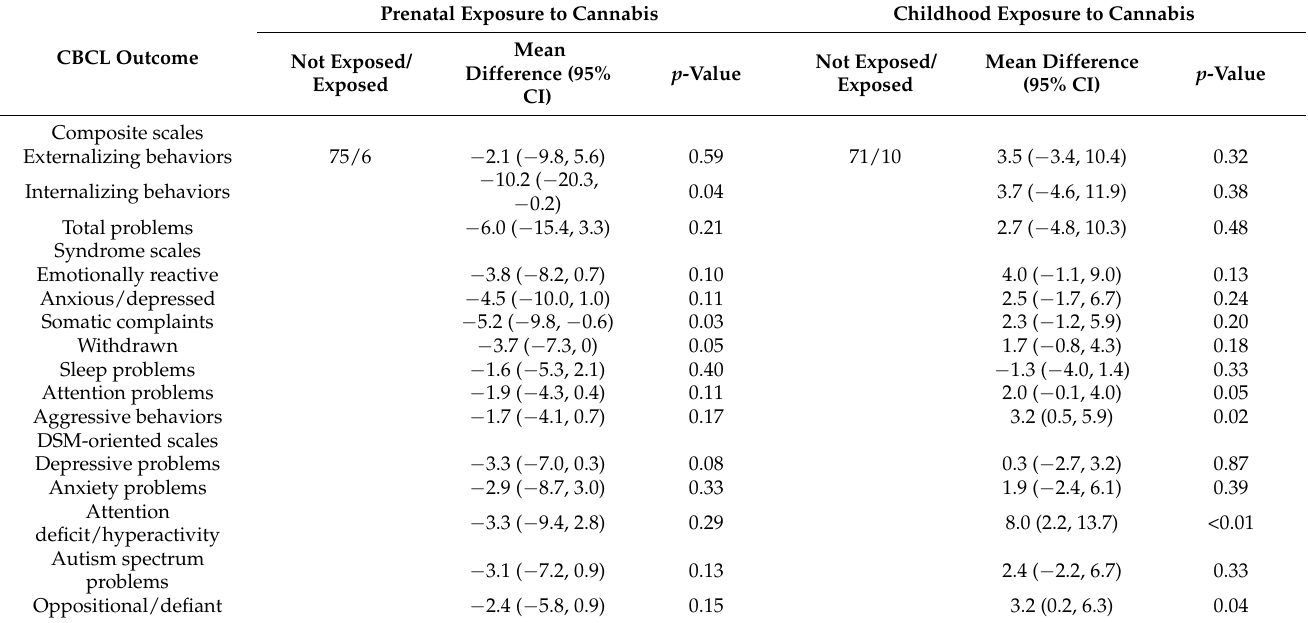
Table 4. Associations between prenatal and childhood exposure to cannabis with childhood behavior, n = 81.